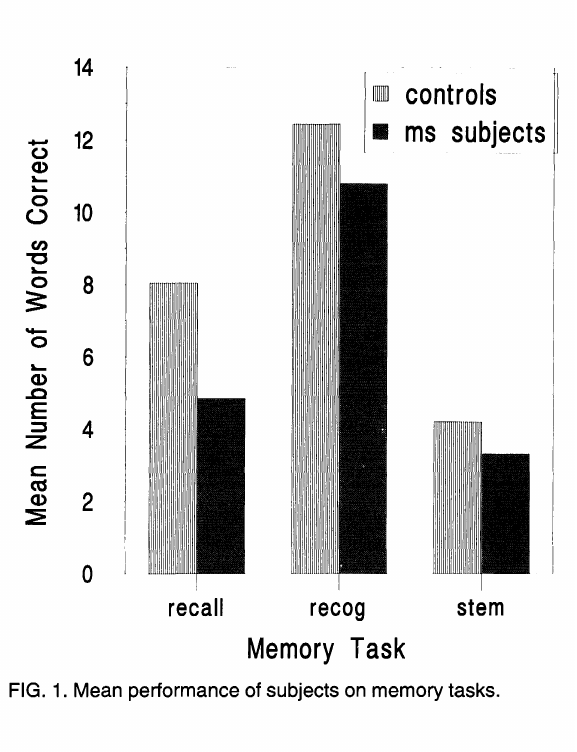
puted. This produced a coefficient (r = - 0.736, df = 10, p = 0.001) only slightly lower than the original corre lation. Disability status, therefore, did indeed correlate with stem completion. Duration of MS did not correlate with performance on the memory